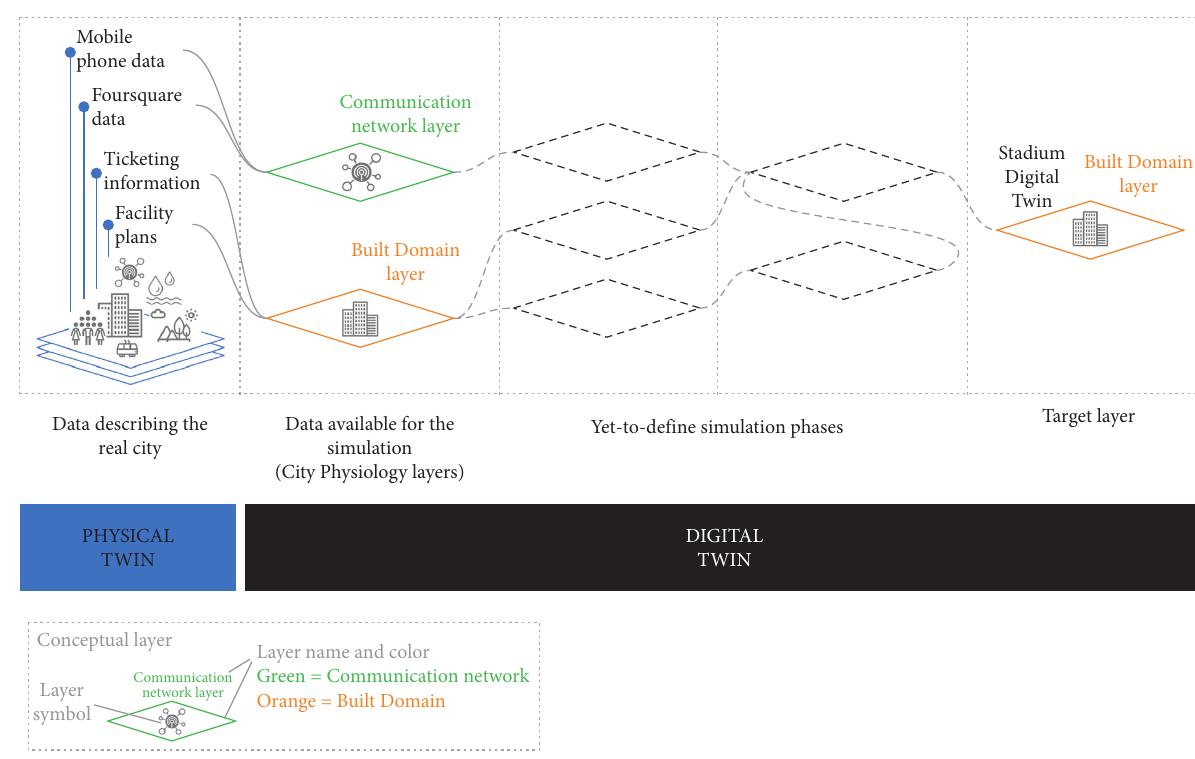
Figure 1: Problem definition and identification of data layers. The definition of the case study determines the target layer, which is the Built Domain (last column). The real city (the physical twin) produces the data available for this simulation. The data belong to two of the nine layers that City Physiology identifies as the fundamental systems of a city: the Communication Network and the Built Domain , which is also the target layer. Data availability, on one side, and the aim of the case study, on the other, define which conceptual layers are available for simulation, as depicted in the 2nd and last column. In between them, the dashed lines represent the layers that will be defined in a 2nd step. Created using icons from the noun project (https://thenounproject.com – “environment” icon by iconixar, “ecosystem” icon by Kamin Ginkaew, “buildings” icon by Ralf Schmitzer, “Society” icon by David Garc´ıa, “Water” icon by Icongeek26, “Tram” icon by Andrejs Kirma, and “Network” icon by Priyanka) under a CC